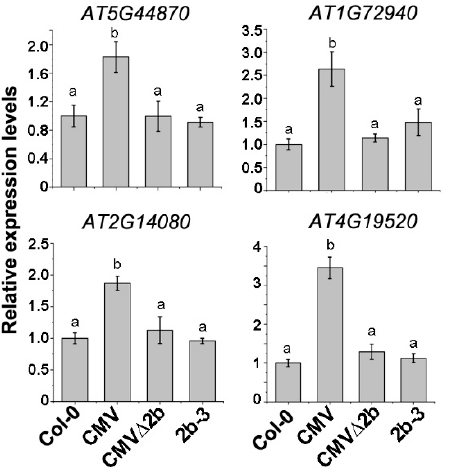
Figure 5. The relative expression of R genes in CMV-, CMV Δ 2b- and 2b-3 plants. Means identified by different letters are significantly different from each other. Error bars represent SEs from three biological replicates. One-way ANOVA followed by Tukey’s multiple comparisons test, was used for statistical analysis ( P < 0.05).